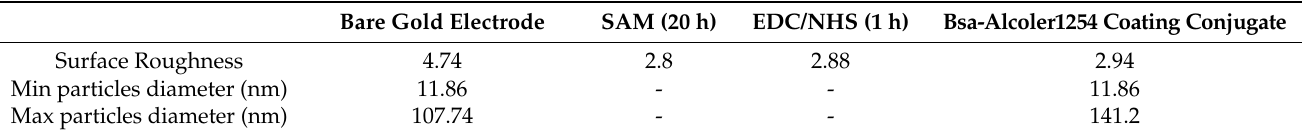
Table 2. Surface roughness and particle diameters of bare and modified gold